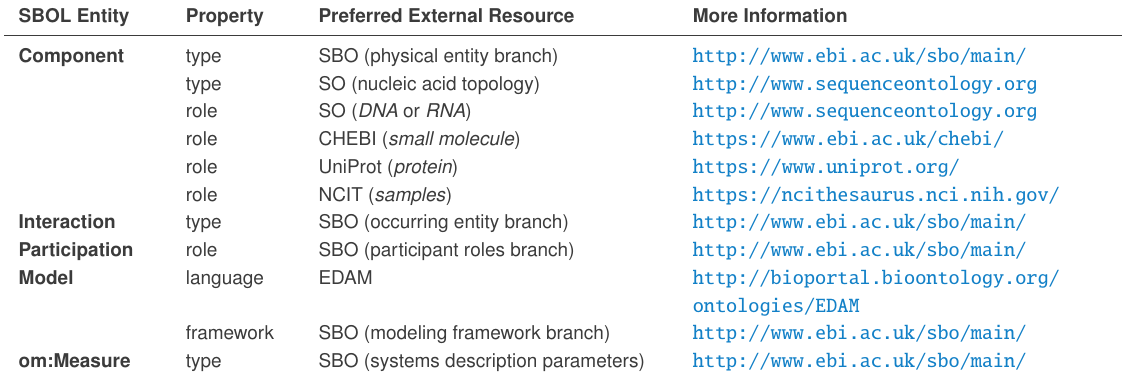
Table 16: Preferred external resources from which to draw values for various SBOL